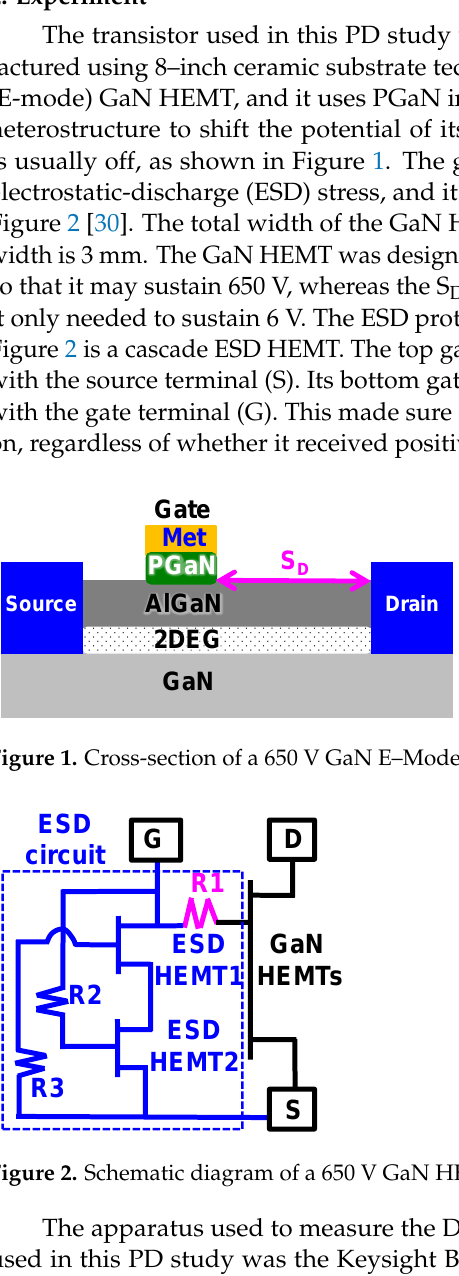
Figure 3. Setup for the PD observation of the GaN HEMTs during the breakdown voltage V bk meas- urement. 3. Results The PD of the GaN HEMTs was affected by defects [11,14], atmosphere pressure, temperature, and the space between pads (d), in accordance with V bk = k 2 d, where k 2 = 97 V/ μ m [31]. The atmosphere pressure and temperature are external to the GaN HEMTs, whereas the defects are internal. The component of the GaN HEMTs that is used to con- nect its interior and exterior is the pad, which is the only conductive material of the tran- sistor that is exposed to air. In this experiment, the parameter used to study the PD be- havior of this GaN HEMTs was the temperature. From the measurement result, the thresh- old temperature of the PD in the air for this GaN HEMTs was 150 °C. Below this temper- ature, no PD occurred with the GaN HEMTs in Figure 2, since the voltage required to induce a PD in the air would have been higher than its breakdown voltage V bk . In this paper, the temperature used to investigate the PD phenomenon for the GaN HEMTs was 175 °C. 3.1. Measurement Result Figure 4 shows the drain voltage (V D ) waveform of the 650 V GaN HEMTs with the gate protection circuit in Figure 2 immersed in the electronic liquid, Fluorinert (FC – 770), under an 800 V, 50 ms single pulse, at 175 °C. Since the device breakdown voltage was greater than 900 V at 175 °C, the drain voltage V D of this 650 V GaN HEMTs remained constant, without any changes during the whole stress period as it was immersed in the electronic liquid to prevent a PD in the air; however, it is evident that the drain voltage V D and current I D were only able to remain at 800 V and 0 A for a while (from 10 ms to 25 ms in Figure 5a) as the 650 V GaN HEMTs was then exposed to air, and it was no longer immersed in the electronic liquid. Consequently, the drain voltage V D oscillated between ~800 V and ~200 V, and a spike in current occurred at the voltage drop-down transient due to a PD in the air during the period of time between 25 ms and ~31 ms (region A of